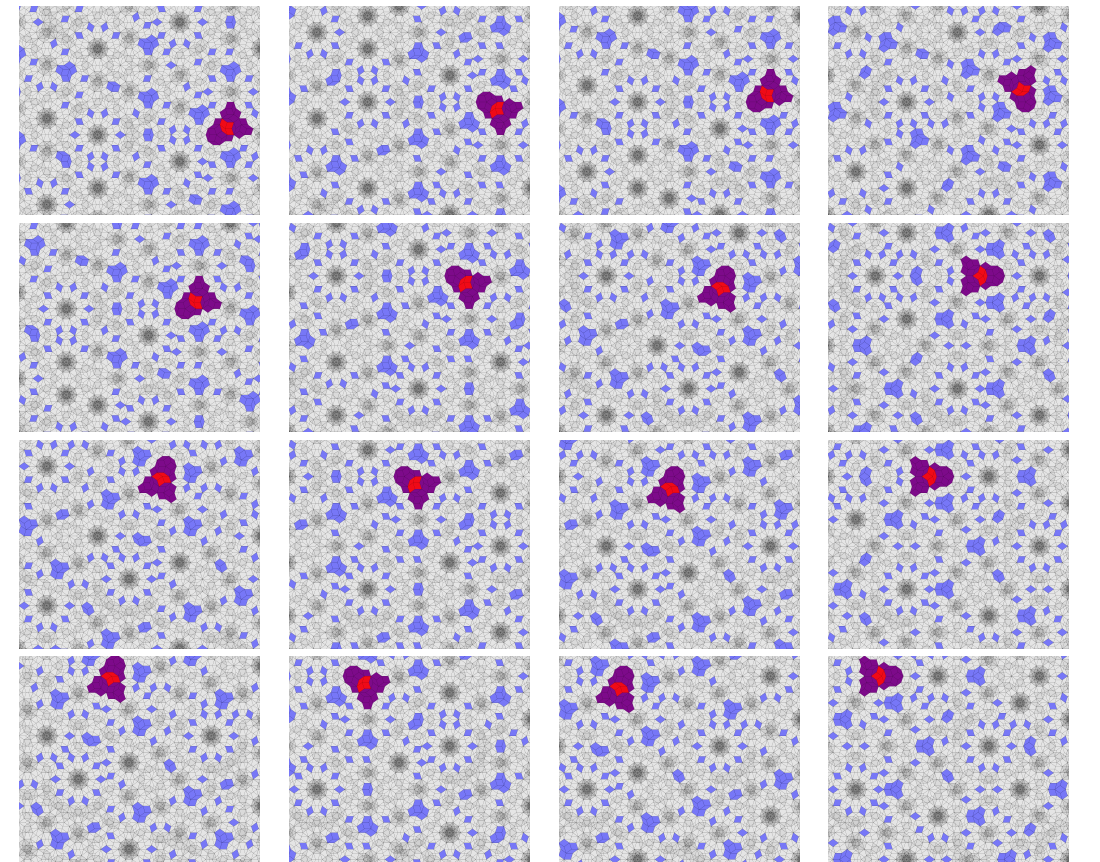
Figure 5. Single particle game of life based on the non-local empire field and the least change principle with alternating hinge variable choices. The order of the frames is from left to right, upper panels to lower panels. In the chosen Penrose tiling patch, the particle moves from the lower right corner of the patch to the upper left corner. The dynamical evolution of the quasiparticle can be seen in the movie at